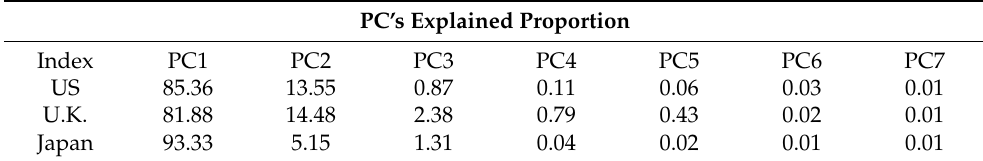
Table 2. Explanatory power of the PCs of the three